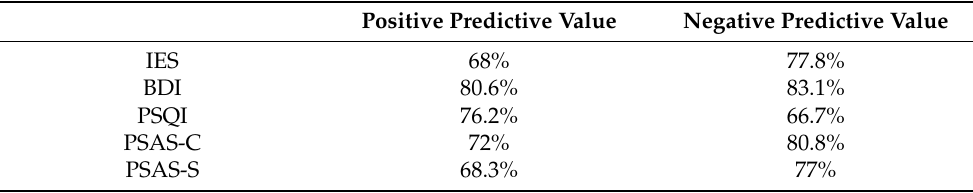
Table 3. Positive predictive value and negative predictive value for IES, BDI, PSQI, and PSAS.